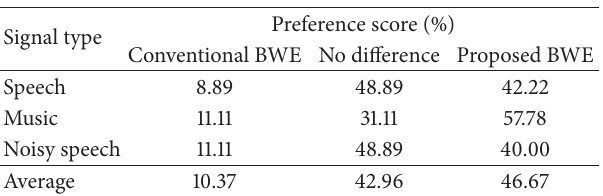
Table 2: Preference test